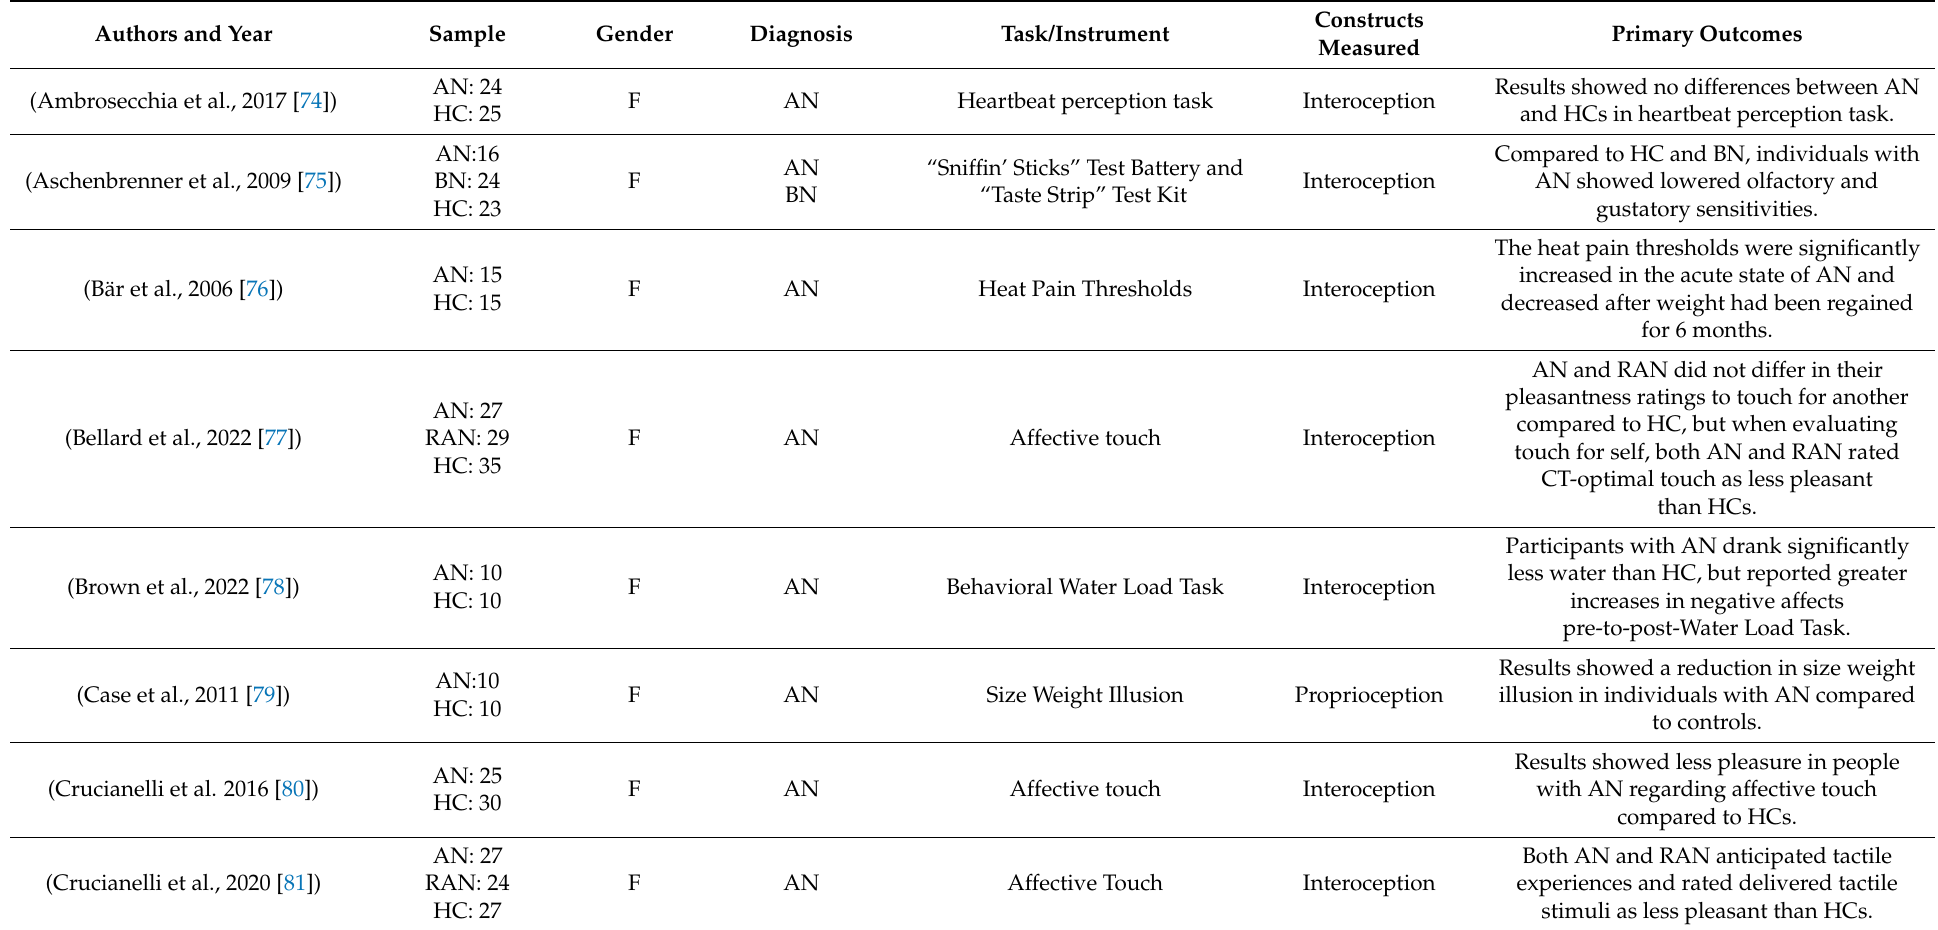
Table 1. Studies characteristics according to extraction